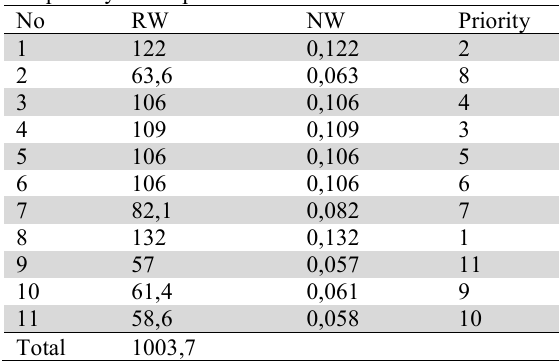
Fig. 4. House of Quality